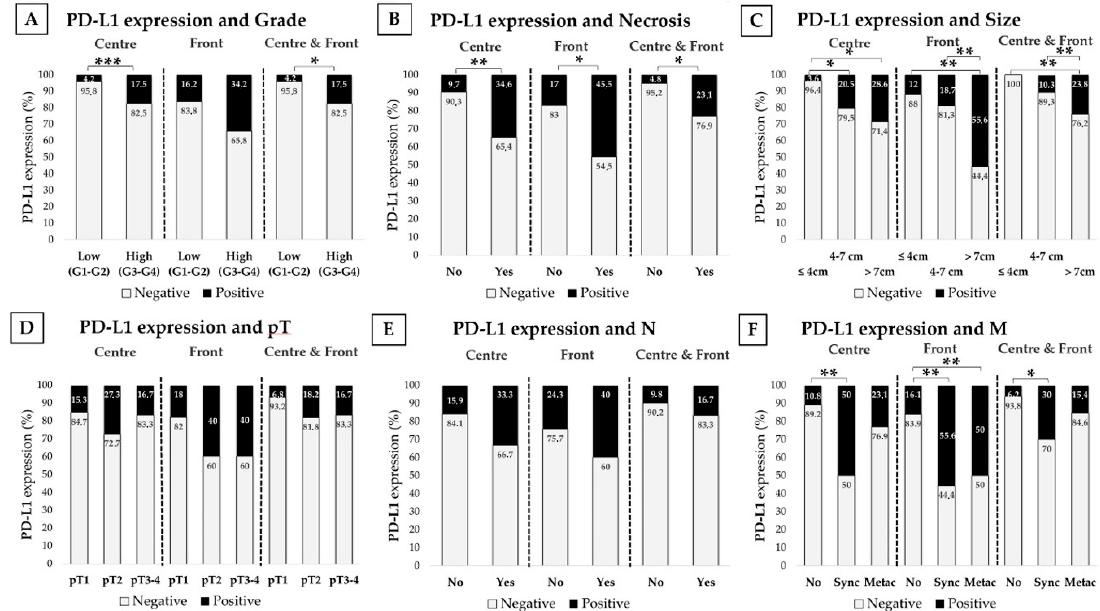
Figure 2. Immunohistochemical PD-L1 staining in terms of the CCRCC aggressiveness. PD-L1 immunostaining at the tumor center, infiltrating front and simultaneously at both areas depending on histological grade ( A ), tumor necrosis ( B ), diameter ( C ), local invasion or pT ( D ), lymph node metastasis or N ( E ), and distant metastasis or M ( F ). PD-L1 staining intensity was scored as negative or positive. Chi-Square test * p < 0.05; ** p < 0.01, *** p < 0.001.